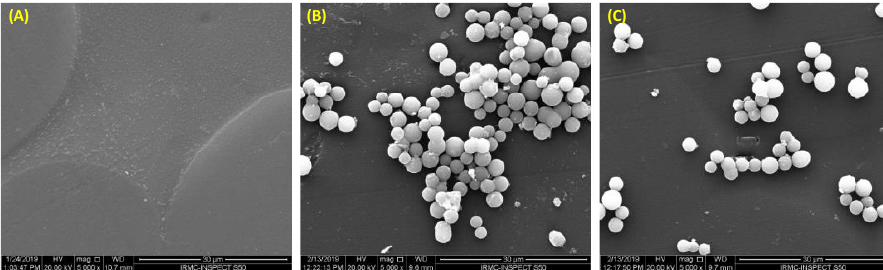
Figure 2: Scanning Electron Microscope (SEM) images of the black substrate and the microbial cells. (A) Denture base resin prior to biofilm challenge, (B) Candida adhesion to the conventional denture base resin, and (C) Candida adhesion on the antimicrobial denture base resin